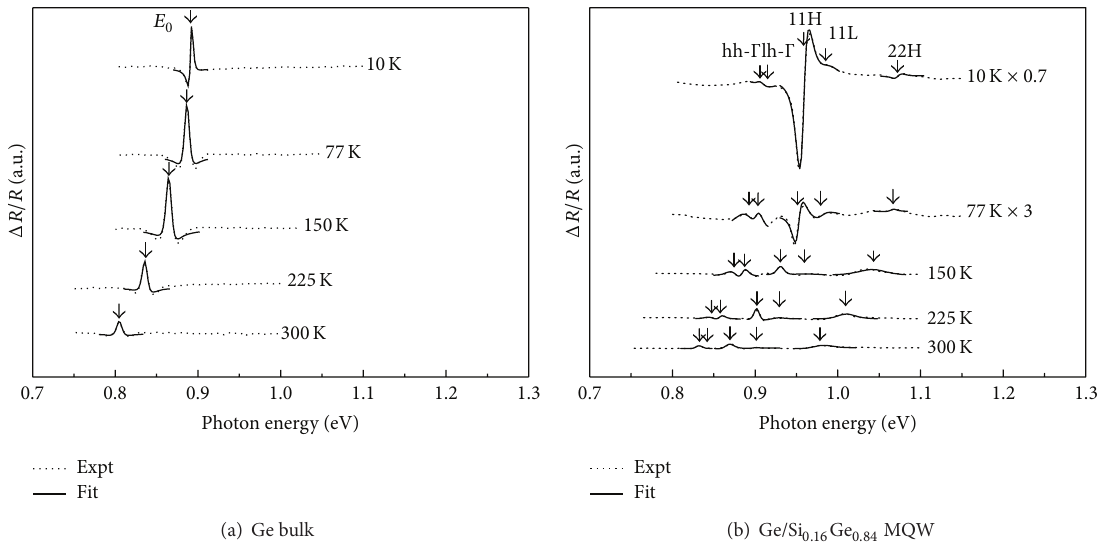
Figure 3: Temperature-dependent PR spectra for (a) Ge bulk and (b) Ge/Si 0.16 Ge 0.84 MQW structure at several temperatures between 10 and 300 K. The dashed curves are the experimental curves and the solid curves are the least-squares fit to the first-derivative Lorentzian line shape. 0.95